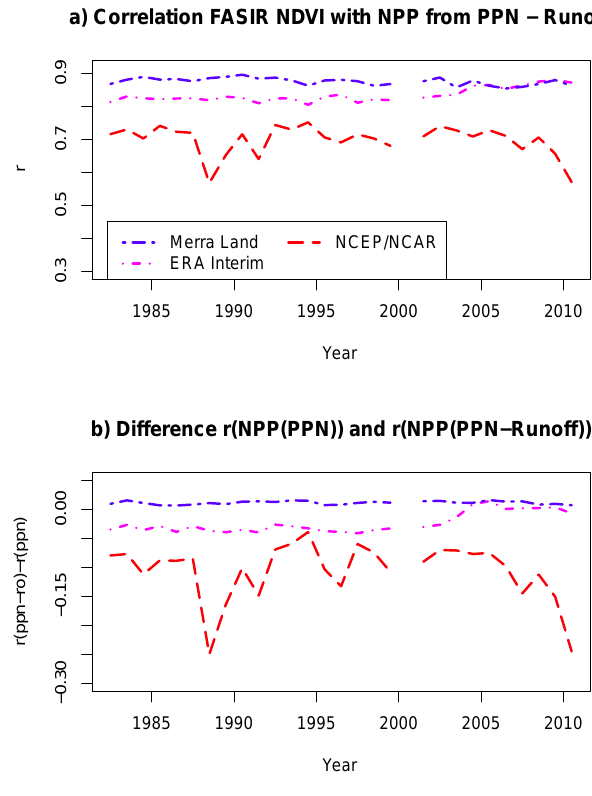
Figure 9. Evaluation of spatial agreement through time between potential annual NPP from precipitation minus runoff and mean an- nual